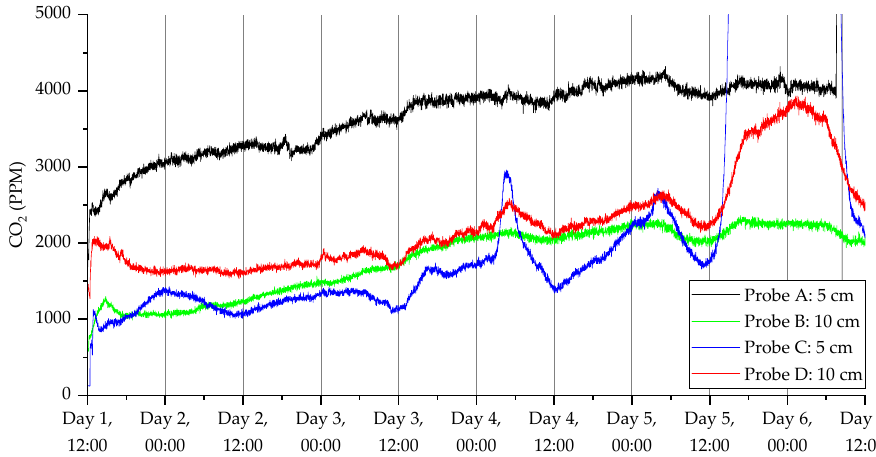
Figure 9. CO 2 measurements for the deployment in Warwick campus woodland. Data collection commenced on 11 November 2021 at 12:40 (24 h time).